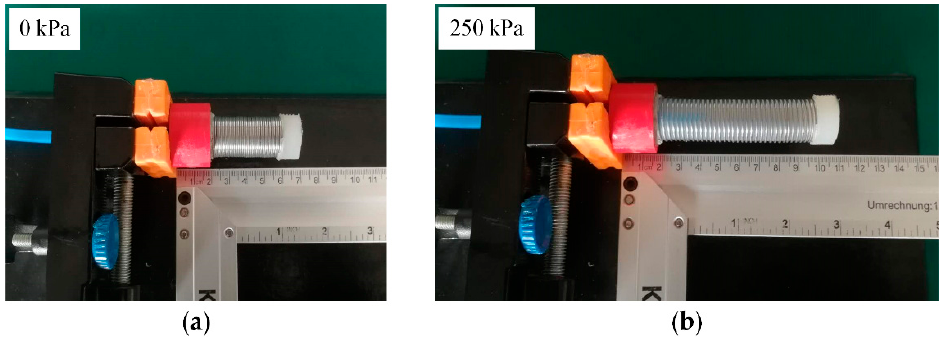
Figure 4. Deformation of the soft actuator: ( a ) initial state at 0 kPa; ( b ) pressurized state with 250 kPa.